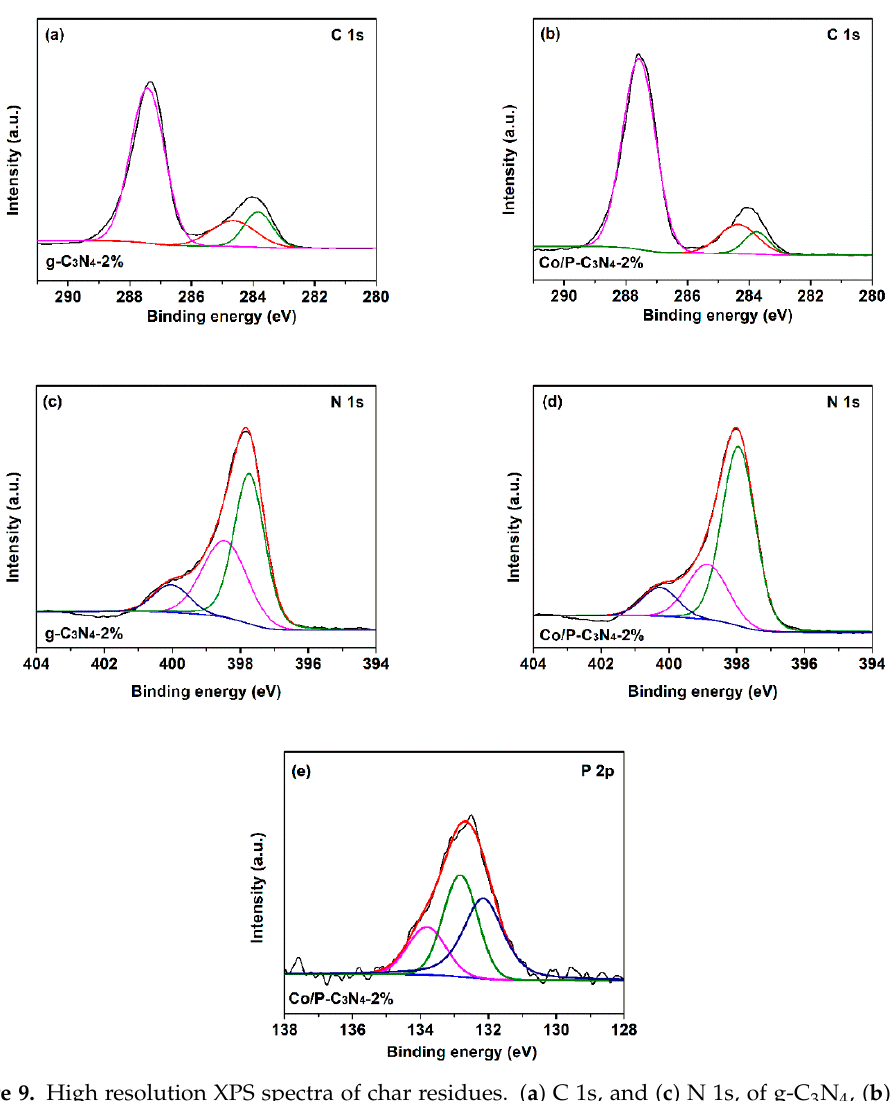
Figure 9. High resolution XPS spectra of char residues. ( a ) C 1s, and ( c ) N 1s, of g-C 3 N 4 , ( b ) C 1s, ( d ) N 1s, and ( e ) P 2p, of Co / P-C 3 N 4 .